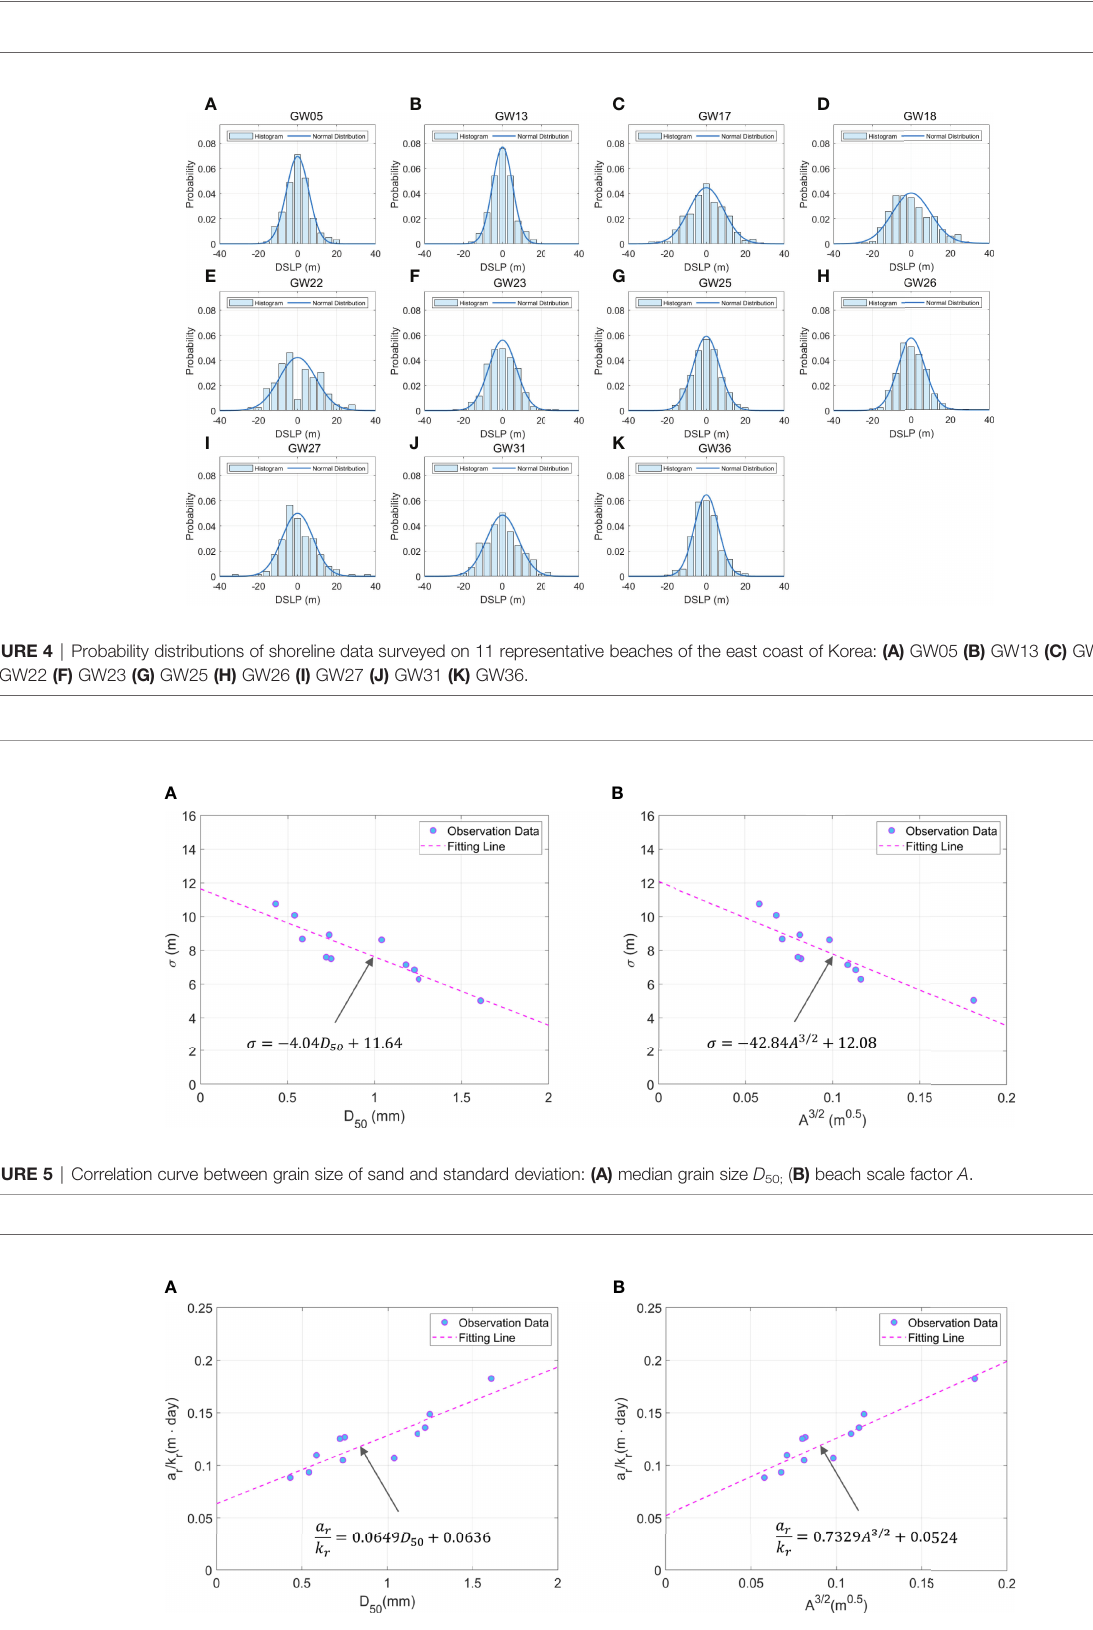
FIGURE 6 | Correlation curve between grain size of sand and a r /k r : (A) median grain size D 50; (B) beach scale factor A.